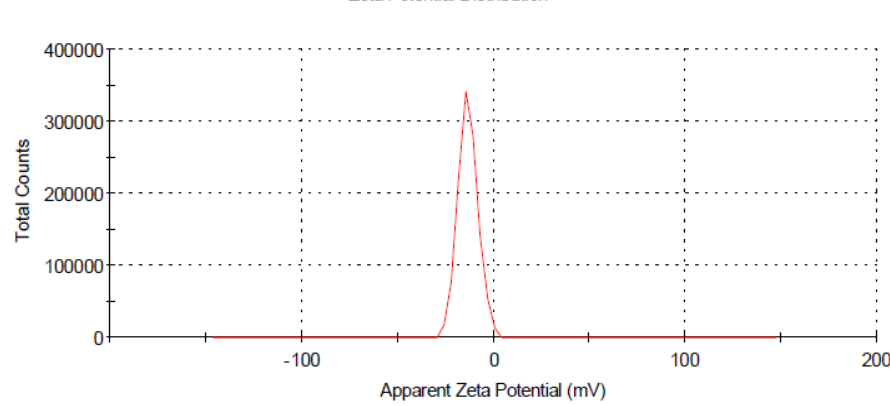
Figure 3. Zeta potential for curcumin nanoparticles.